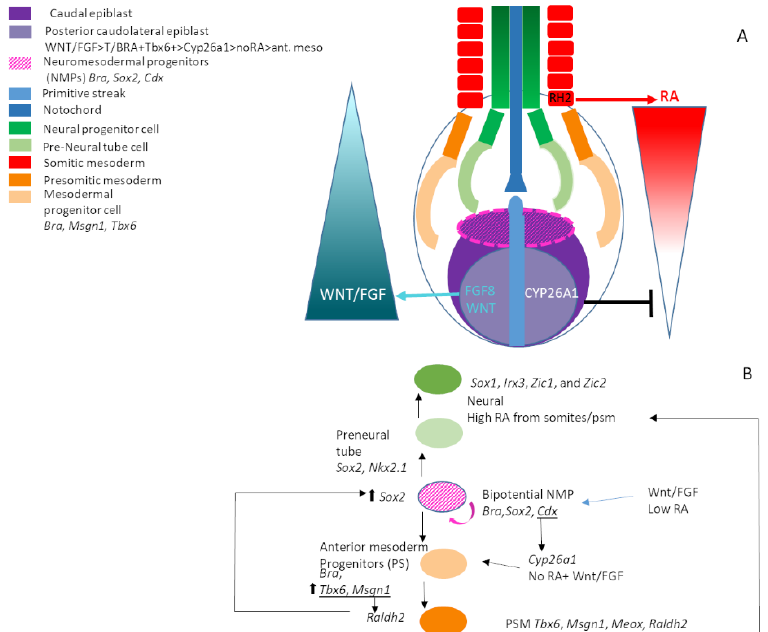
Figure 5. CYP26 enzyme function in neuromesodermal progenitor and axial elongation during development. ( A ) Schematic of posterior axial development, neuromesodermal progenitors and morphogen gradients. Expression of Cyp26a1 in the posterior caudolateral epiblast in combination with FGF / WNT signalling and RA synthesis by Raldh2 in the somatic mesoderm and epiblast establishes a posterior RA gradient required to promote caudal axial elongation. Axial elongation requires the establishment and maintenance of a neuromesodermal progenitor pool in the caudal epiblast at the anterior end of the regressing primitive streak. Bipotential NMPs can di ff erentiate either to neural or mesodermal specifications and a balance between these fates is required for normal axial development. ( B ) Schematic of the molecular signals governing bipotential NMP fate specification towards either neural or mesodermal tissue. Posteriorly, CYP26A1-mediated inhibition of RA plus FGF / WNT signalling induces Bra / Tbx6 -positive mesodermal tissue from NMPs. Anteriorly high RA promotes induction of Sox2 / Nkx2.1 pre-neural fates from NMPs. NMPs themselves ( Bra / Sox2 -positive) require low levels of RA for induction and maintenance. In this model, the relative levels of mutually antagonistic RA and WNT signalling control T / Bra and Sox2 expression and regulate the switch between mesodermal and neural di ff erentiation and therefore the proportion of the two cell fates. Adapted from Niederreither and Dolle 2008 [10] and Gouti et al. 2017